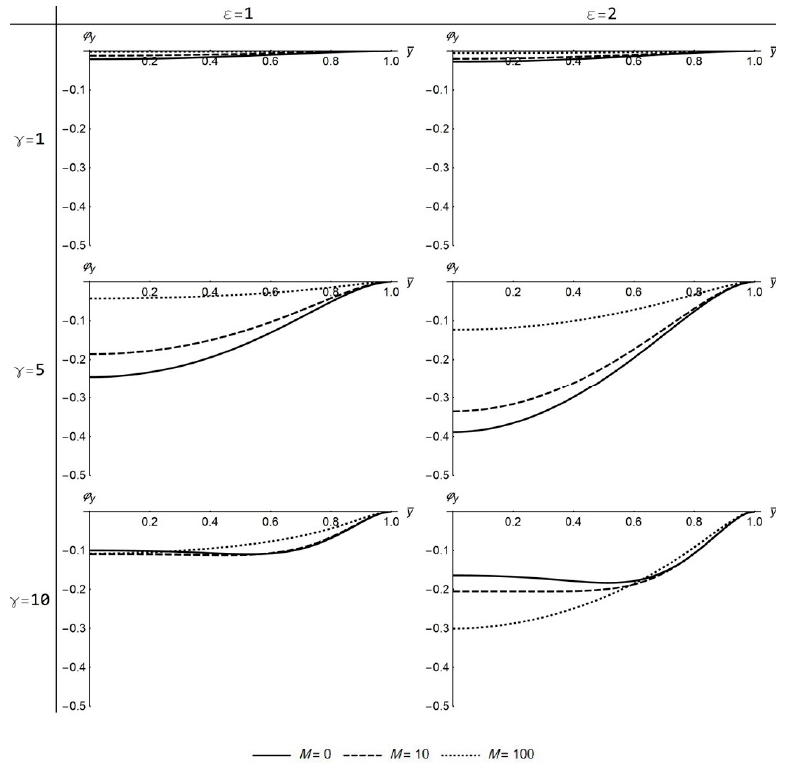
Figure 7. The profiles of 𝜑 (cid:3052) for different values of the 𝜀 , 𝛾, and 𝑀 parameters (transverse case).